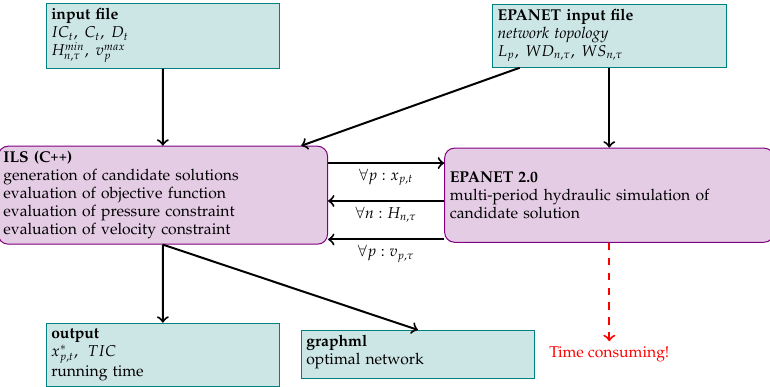
Figure 5. Interaction between iterated local search (ILS) and EPANET